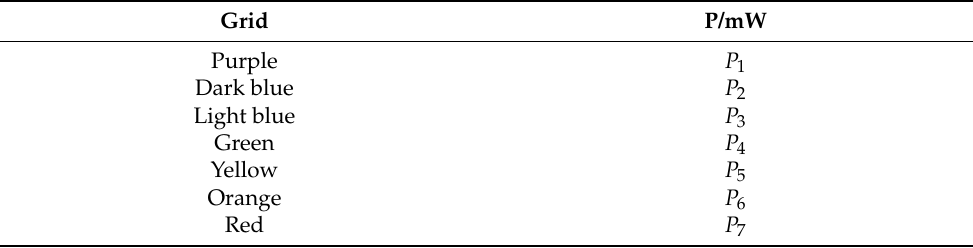
Figure 3. Each color grid represents the power required by the cluster head to transmit the signal. The transmitting power corresponding to different grids is shown in Table 2. (Note that this figure is a demonstration diagram for easy narration, the specific range is adjusted according to the calculation). Table 2. Transmitting power corresponding to different